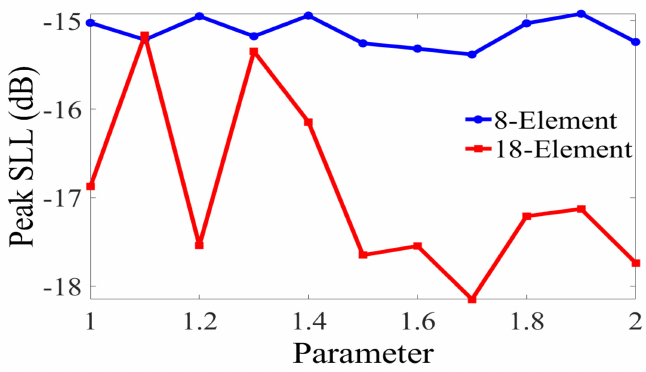
Figure 2. Selection of b1 and b2 for both 8–element and 16–element CAA.